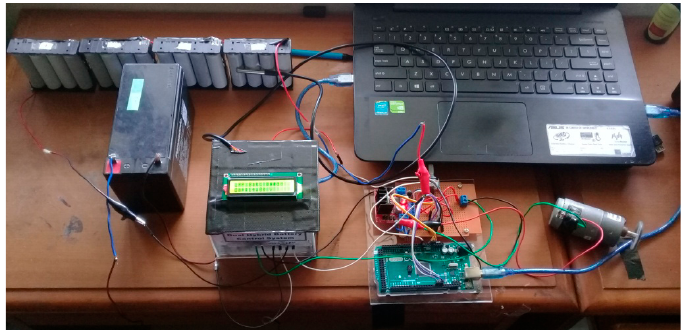
Figure 12. Overall system hardware.